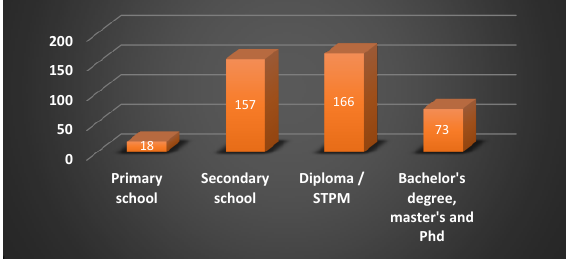
Figure 9. Distributions of respondents by level of education